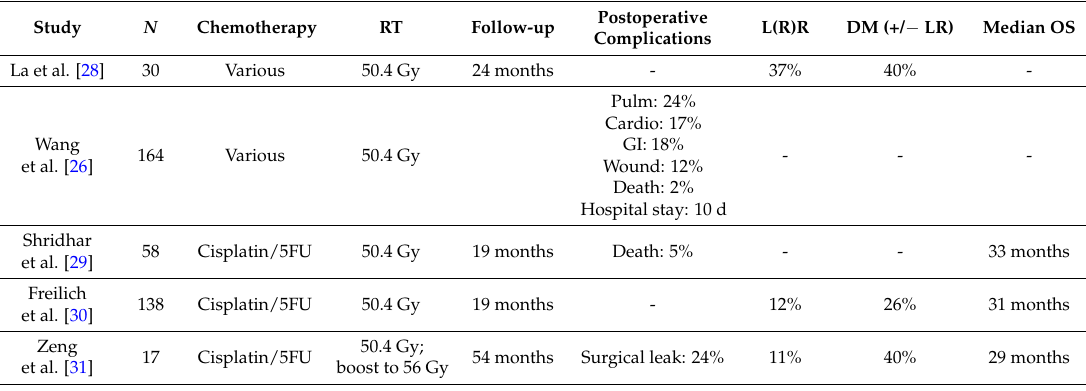
Table 3. Selected retrospective studies examining neoadjuvant intensity-modulated radiotherapy and chemotherapy followed by